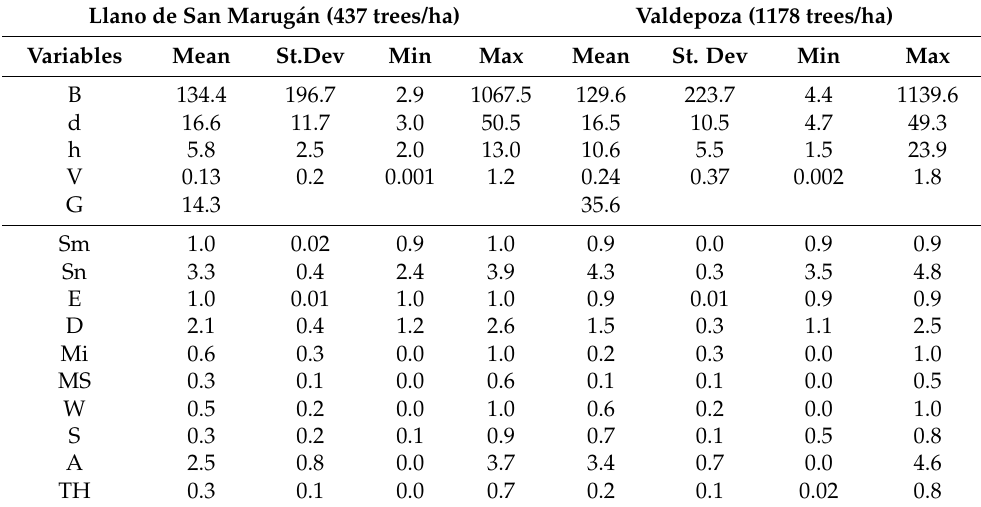
Table 1. Descriptive statistics of stand